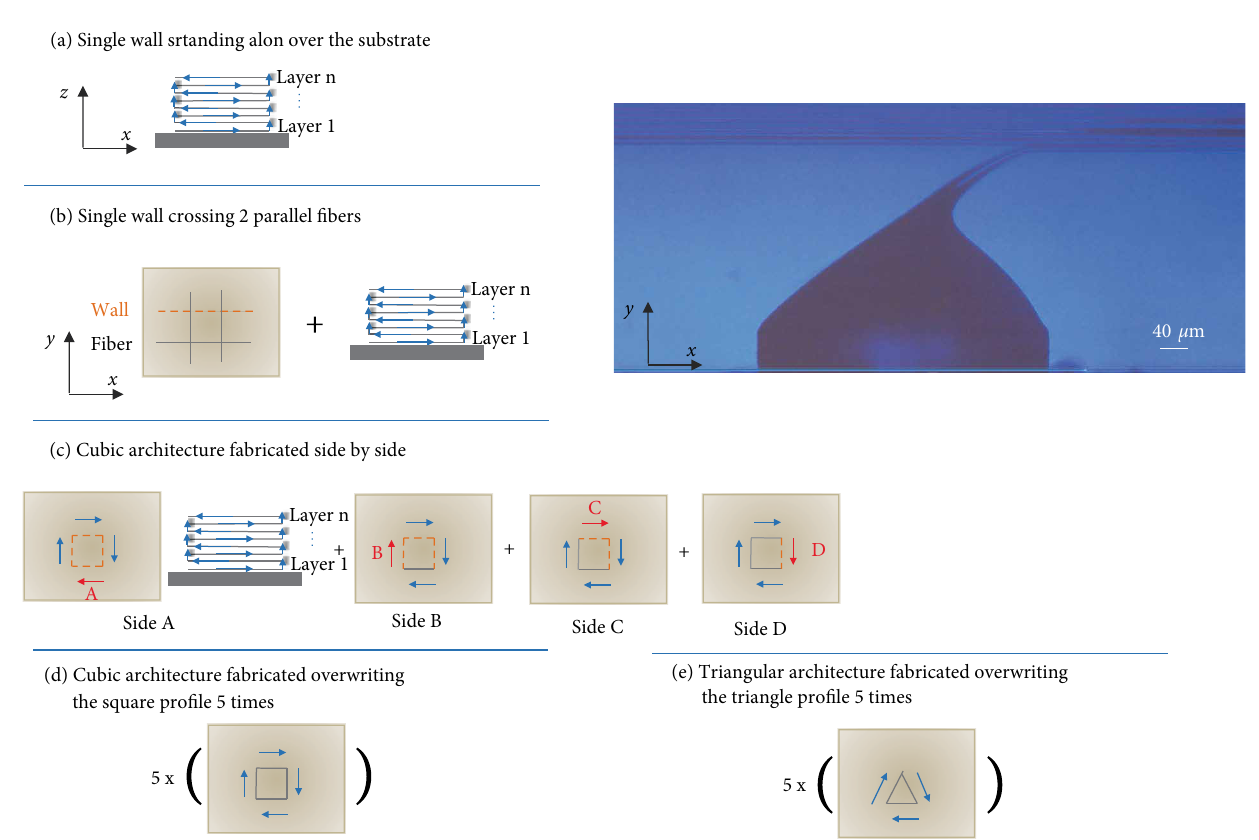
direction was constructed by 𝑧